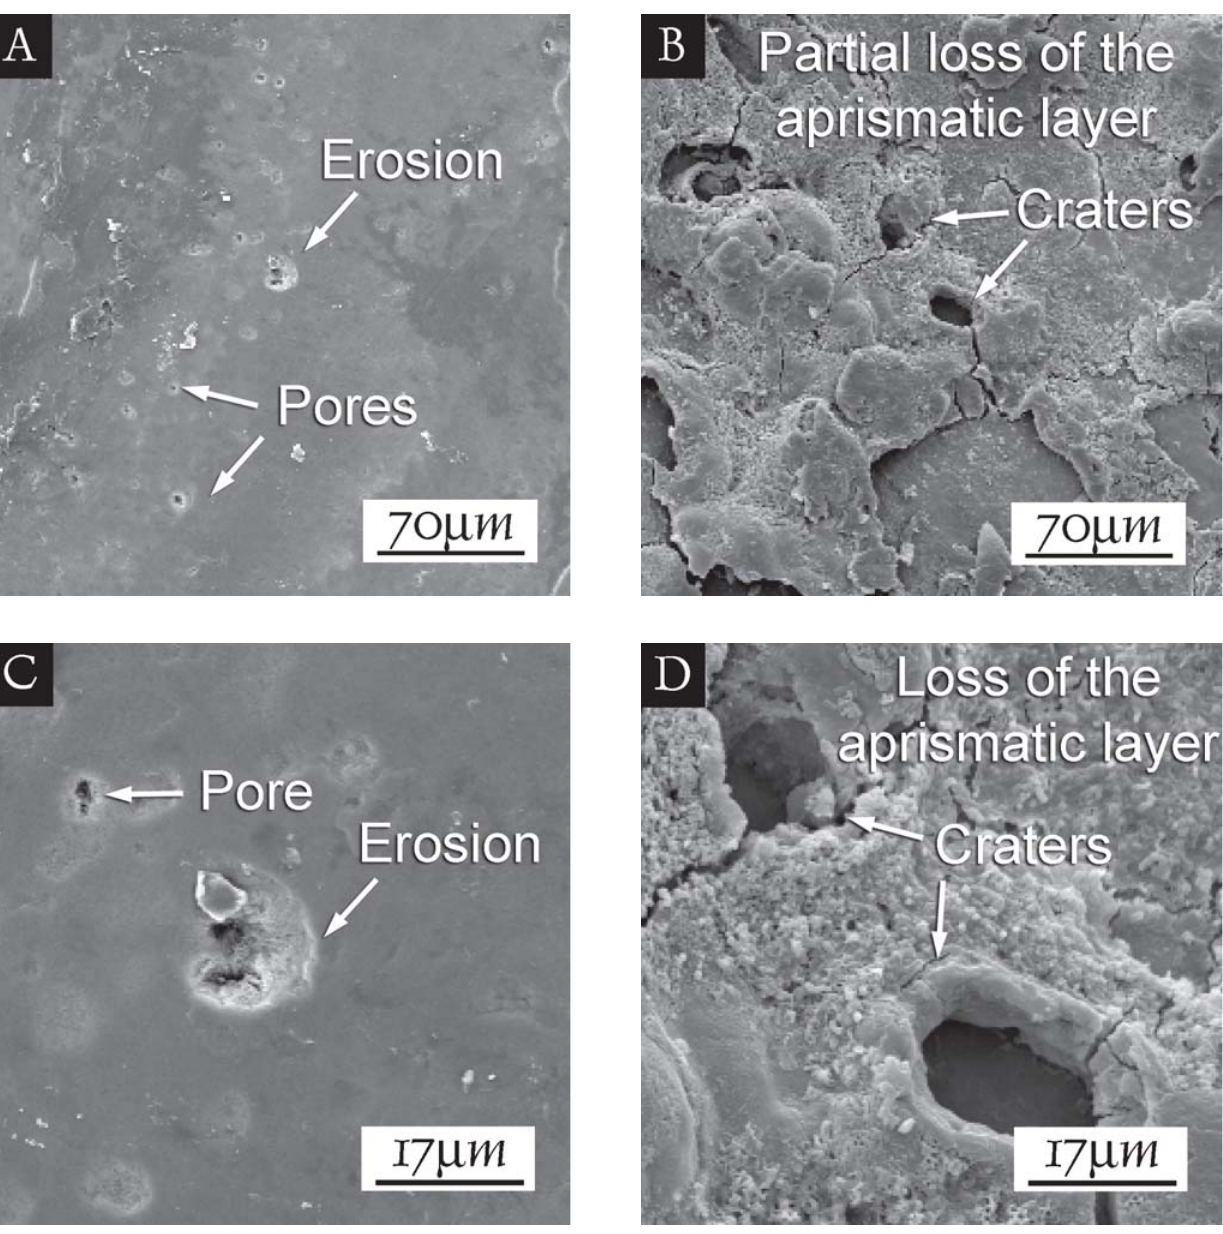
FIGURE 2- Photomicrographs of bleached enamel after 35% carbamide peroxide applications at 500x (A and B) and 2000x magnifications (C and D): removal of the aprismatic layer, craters, pores, and